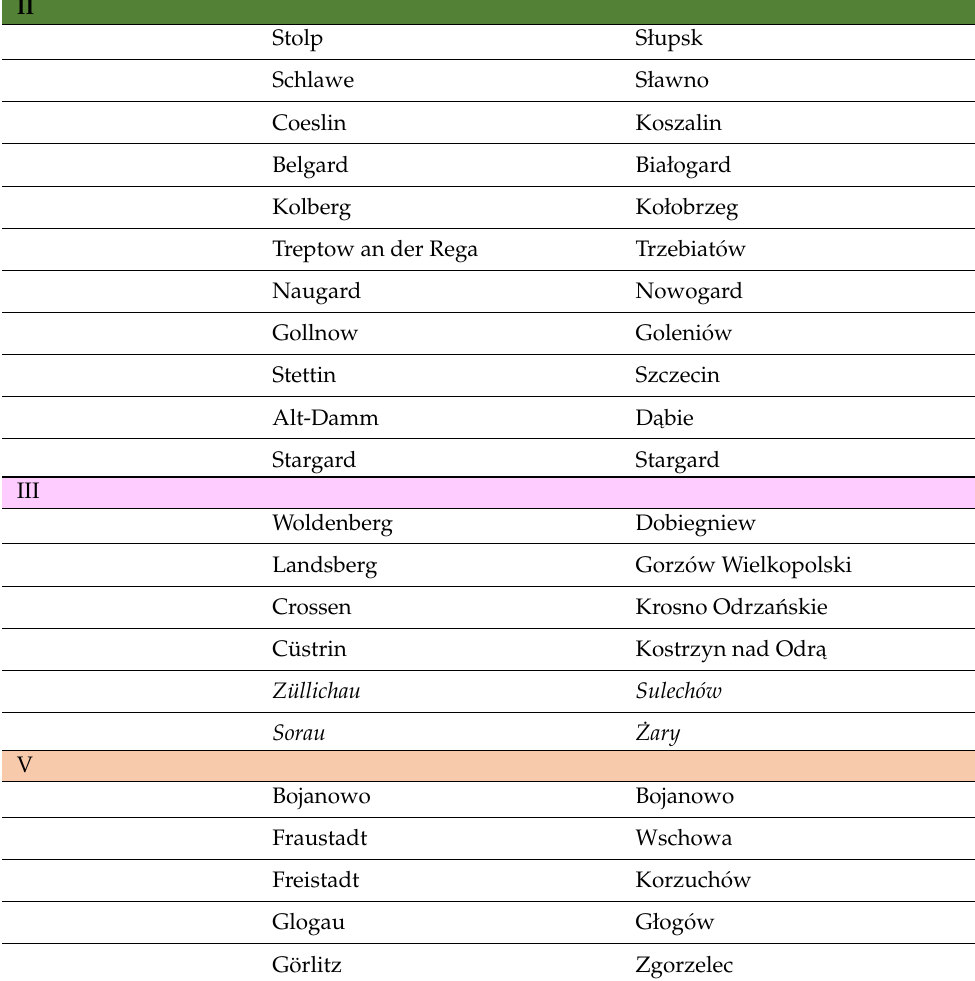
Figure 2. Map depicting the arrangement of garrisons in Prussia and their hierarchy expressed by the positioning of staff headquarters with the approximation of the reclaimed territories border (elabora- tion by M. Rudnicka-Bogusz; map source www.bibliotekacyfrowa.pl (accessed on 30 December 2021); Public Domain Mark 1.0 No Copyright). Table 1. Table listing Prussian garrisons on the present territory of Poland, arranged by Army Corps.